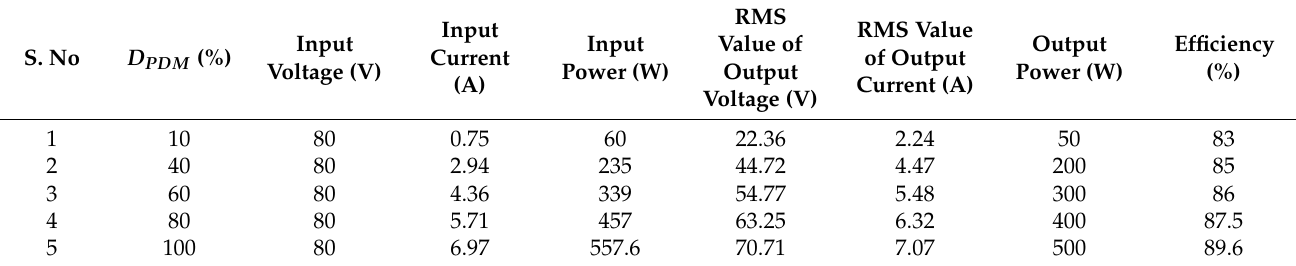
Table 6. Efficiency of pulse density modulation control.